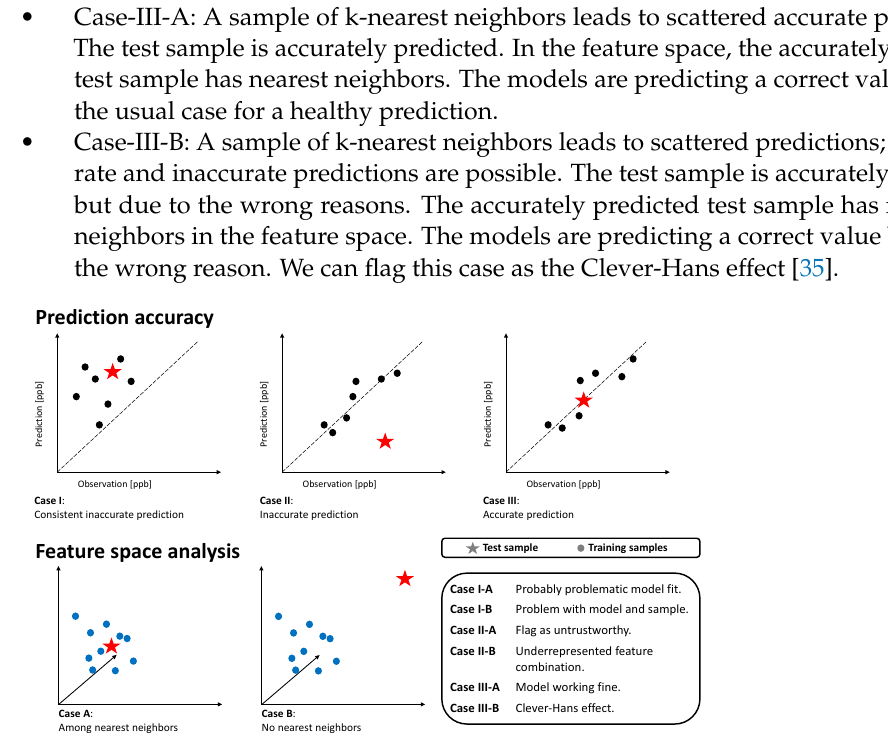
Figure 5. Schematic overview of possible cases. The upper columns show the predictions on k-nearest neighbors training samples and the target test sample with respect to the prediction error. The lower columns depict the k-nearest neighbor analysis in the feature space. Dots represent training samples, while stars depict the test